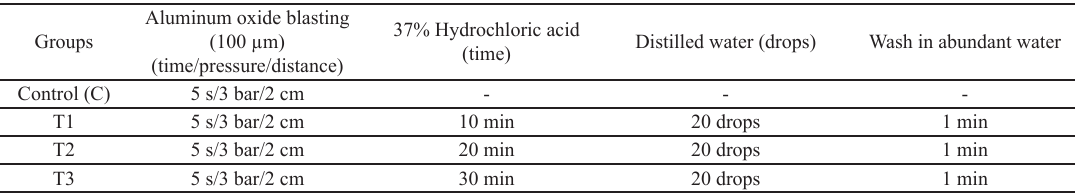
Table 2. Surface treatments applied to Co-Cr dental alloys.